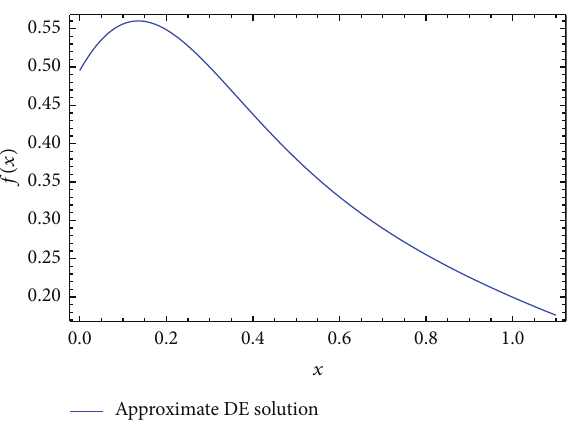
Figure 7: Approximate solution for 𝑦 󸀠󸀠 (𝑥) + 0.4𝑦 󸀠 (𝑥) + 1.1𝑦(𝑥) + 𝑦 3 (𝑥) = 2.1 cos (1.8𝑥) , with 𝑦(0.5) = 0 and 𝑦(1) = 1 .